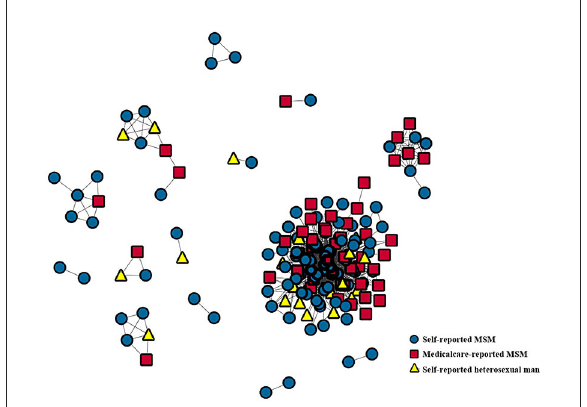
FIGURE1 Positions of three types of pMSM within the sequences clusters. Sequences were generated from the HIV-1 pol. All the sequences contained in networks of pMSM were analyzed by constructing a local MSM HIV-1 genetic transmission network. Medical care-reported MSM and self-reported heterosexual men were always linked to self-reported